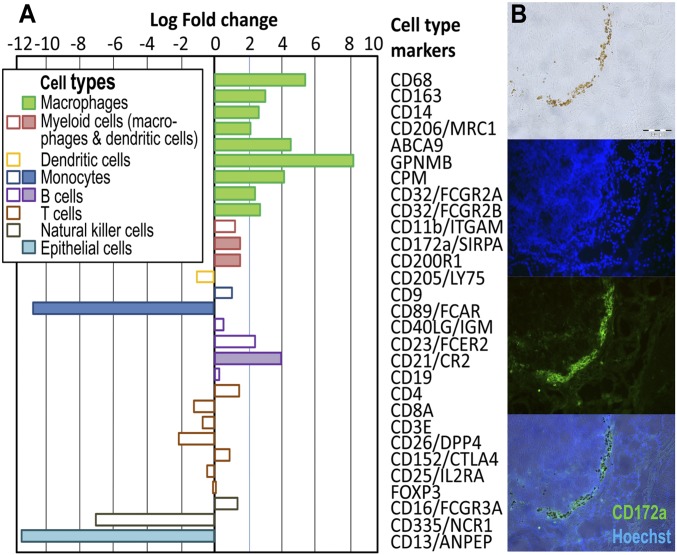
Identification of infiltrating cells in the jejunum of HS cows. (A) Differential gene expression levels of marker genes specific for particular cell types or immune functions. Color-filled bars: significant fold changes, q < 0.05; open bars: nonsignificant fold changes. Negative/positive value indicates lower/higher expression in infiltrating cells from HS cows compared with whole jejunal mucosa of age-matched cows. (B) Fluorescent image of infiltrating cells detected with an antibody against CD172a, marker for dendritic cells, and macrophages [brightfield, Hoechst 33258 (blue), CD172a positive cells (green), merged image]. (Scale bar, 100 µm.)